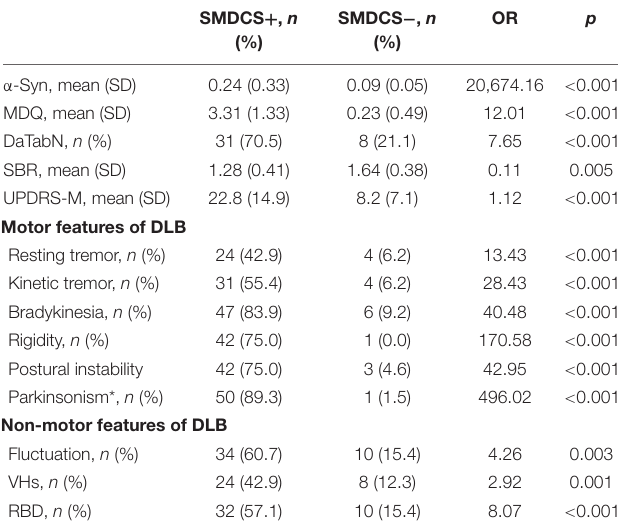
TABLE 3 | Dopamine transporter imaging, motor, and non-motor features of SMDCS + group ( n = 56) compared to SMDCS – group ( n = 65), odds ratio (OR) adjusted for age and dementia severity by